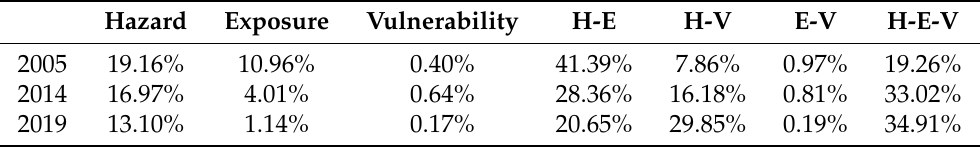
Table A10. Share of each influencing factor from